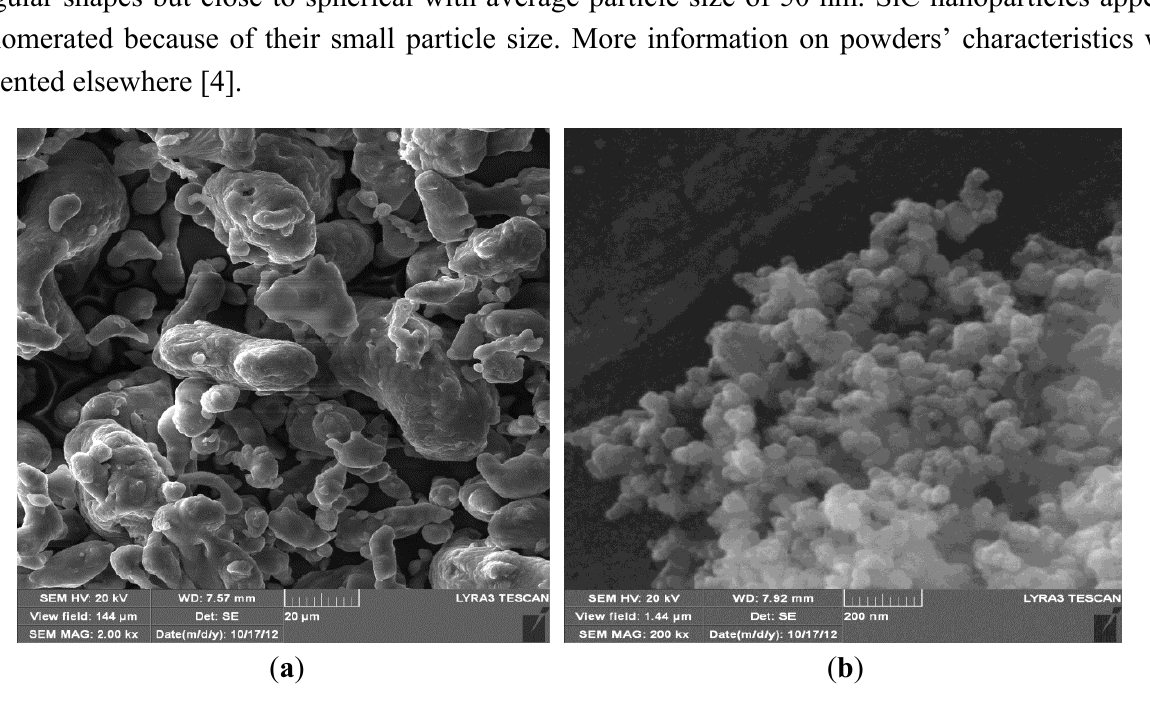
Figure 1. SEM micrographs of as received ( a ) Al and ( b ) SiC powders